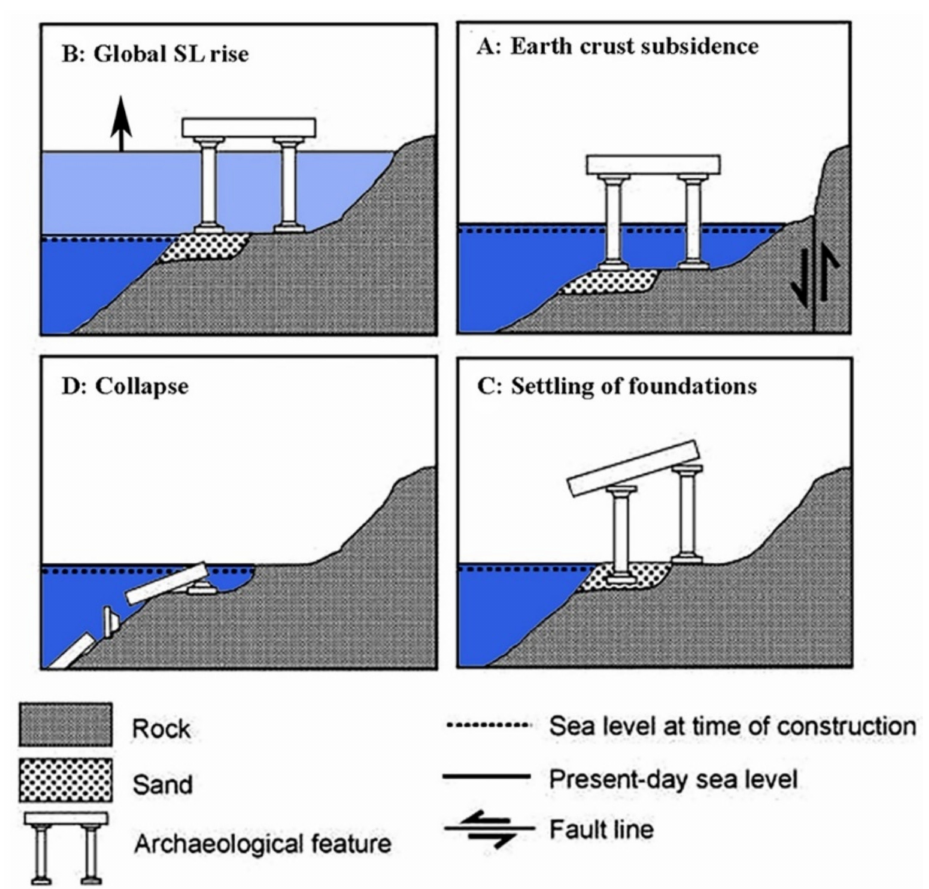
Figure 2. Examples of ancient coastal man-made structures found today in conditions and at an elevation that prevents functioning: ( A ) Earth-crust tectonic or isostatic subsidence, ( B ) global eustatic sea-level rise, ( C ) settlement in unconsolidated sediments, ( D ) erosion and collapse